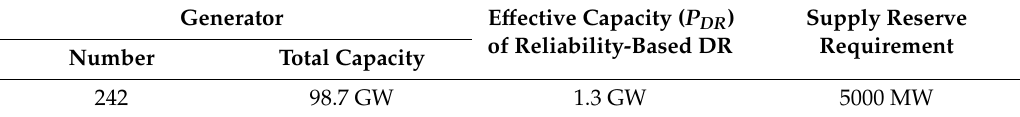
Table 1. Data for generators, reliability-based demand response (DR), and supply reserve requirements.